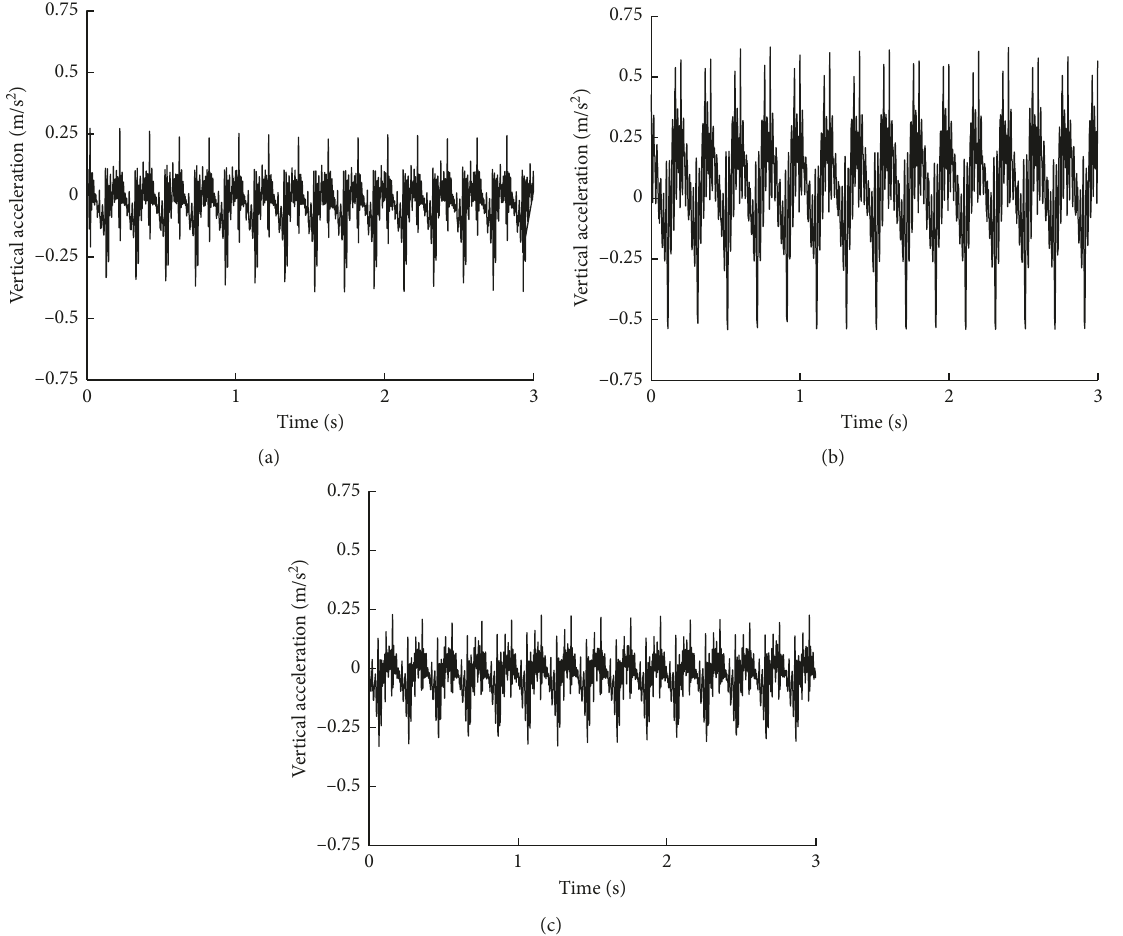
Figure 10: Time-history curve of vertical vibration acceleration of the test point A1. (a) The upper layer of the subgrade bed in normal condition (stage 1). (b) The upper layer of the subgrade bed in mud pumping (stage 2). (c) The model after mud pumping reinforcement (stage